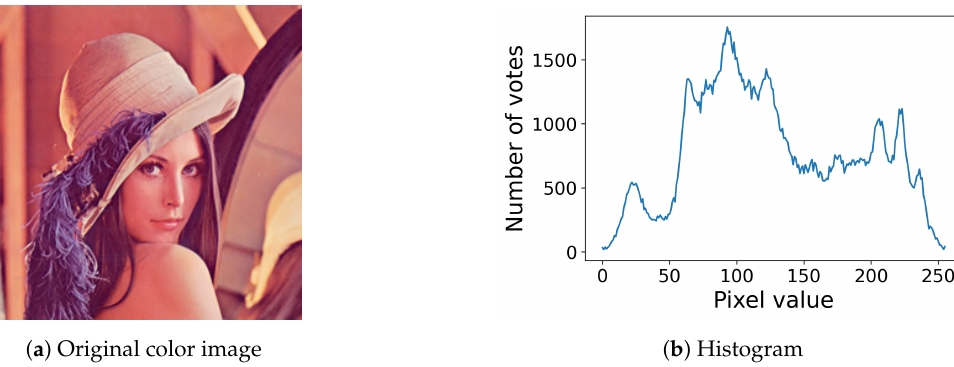
Figure 6. Color image and its histogram: ( a ) an RGB color image with 256 × 256 pixels; ( b ) the histogram of the color image ( a